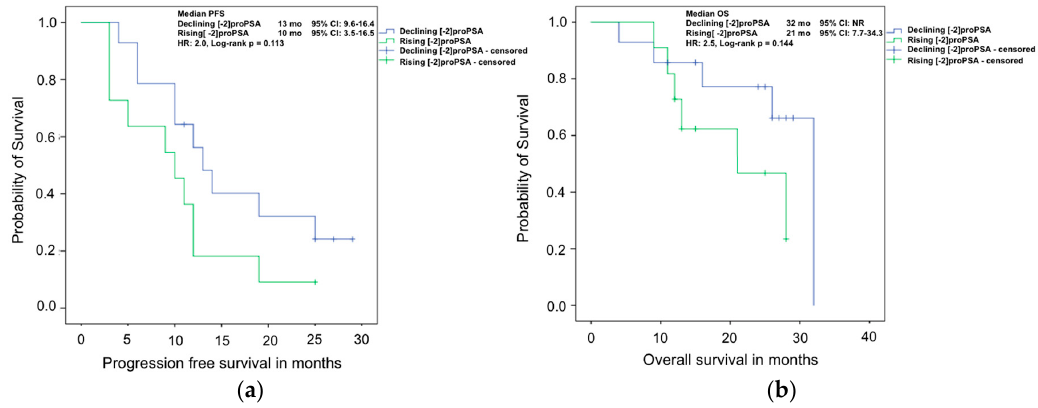
Figure 3. Kaplan–Meier analyses of ( a ) progression free survival; and ( b ) overall survival of mCRPC patients treated with Abiraterone with rising or declining [ − 2]proPSA values after 8–12 weeks of therapy.